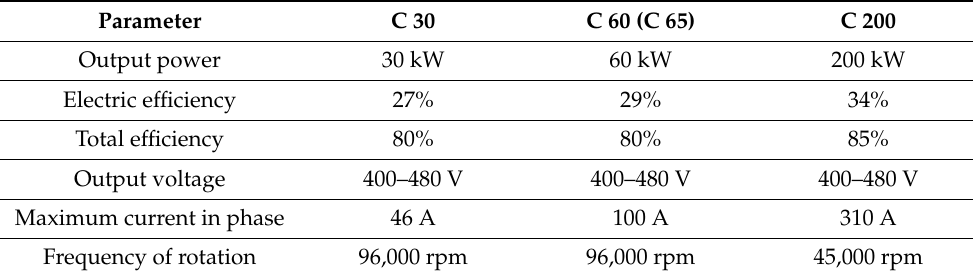
Table 1. Main parameters of Capstone installations.